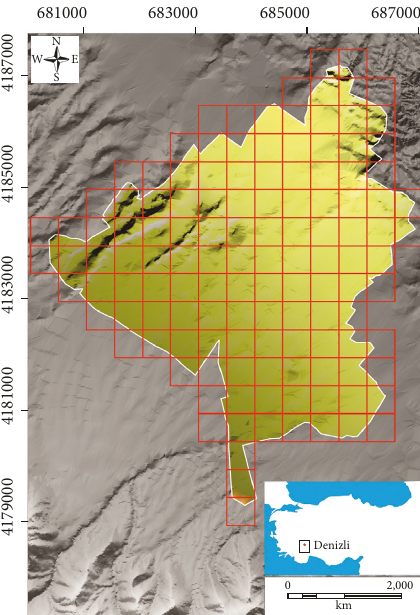
Figure 1: Elevation model of the study area.